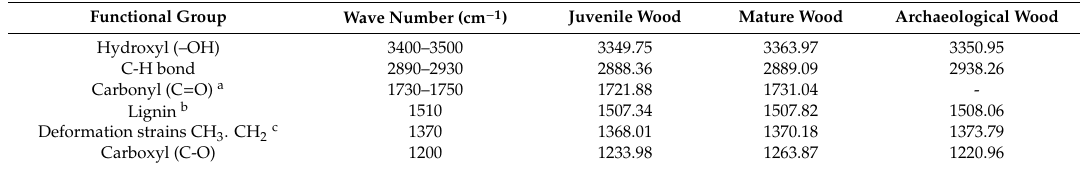
Table 2. Main functional groups present in wood and their absorption band.